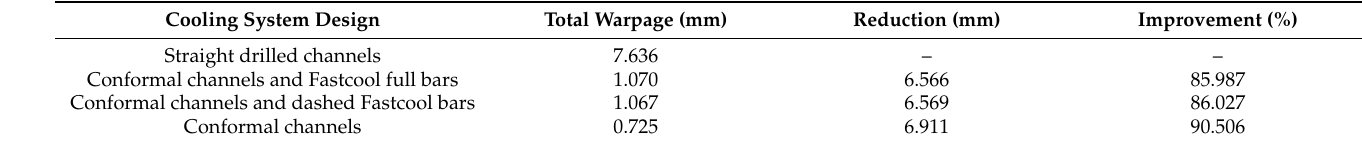
Table 13. Thermally-induced residual stress parameter for each cooling system designs.